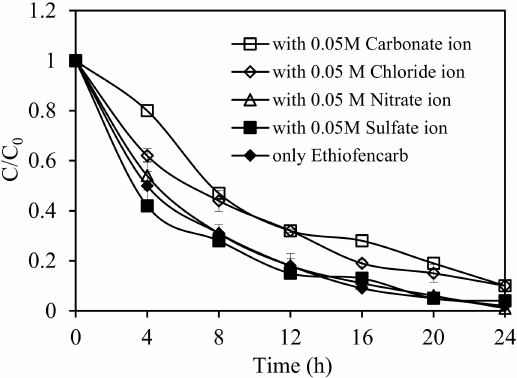
Figure 7. Effect of anions on the photocatalytic degradation rate of ethiofencarb. Experimental conditions: ethiofencarb concentration 10 mg L − 1 ; SnIn 4 S 8 concentration 0.5 g L − 1 ; pH 3.